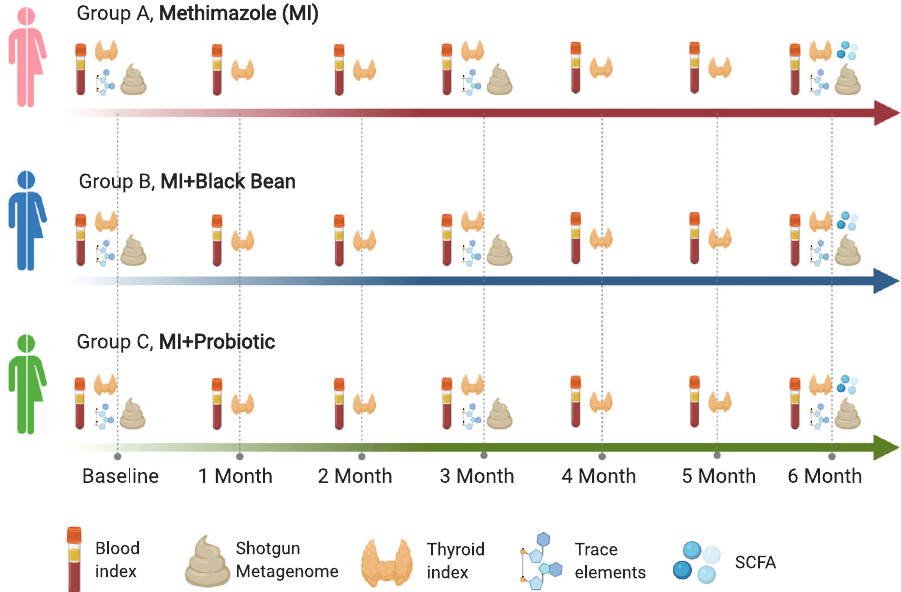
Fig. 1 Experimental design and sampling time points design. We longitudinally tracked blood and thyroid index at every month, gut microbiome determined by shotgun metagenome sequencing, short-chain fatty acids (SCFAs) and trace elements were evaluated at baseline, 3 and 6 months during the 6-month